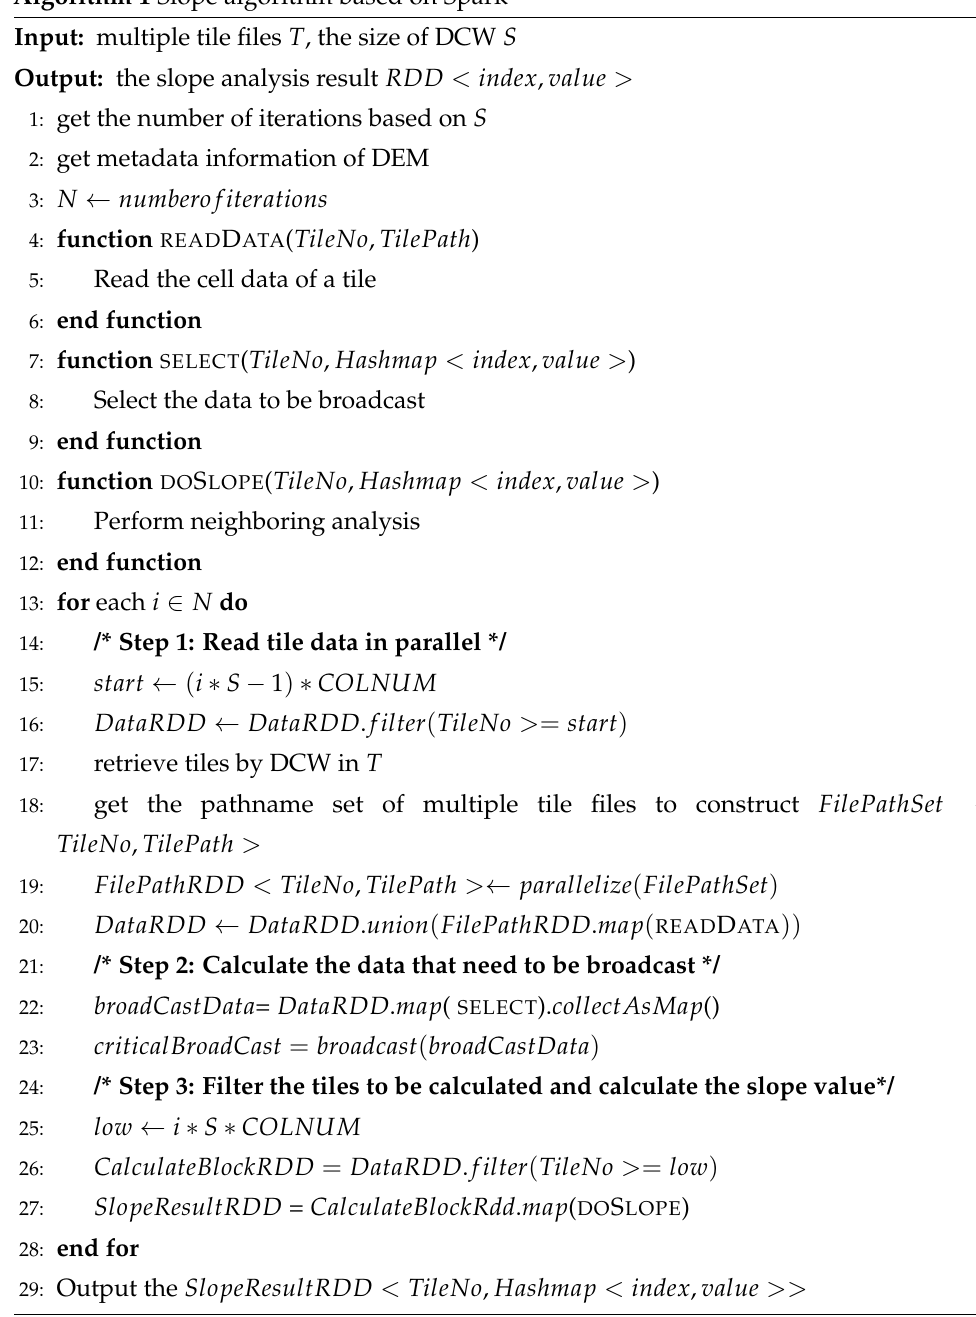
Algorithm 1 Slope algorithm based on